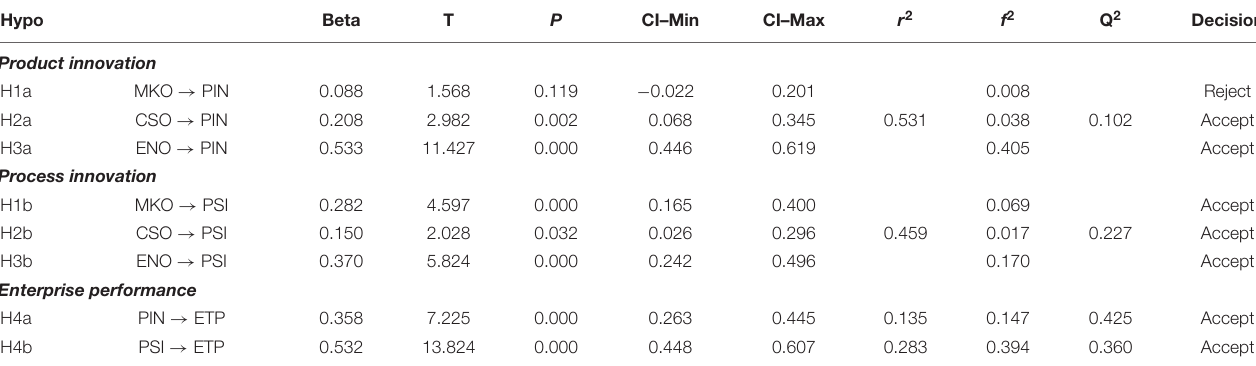
TABLE 3 | Product innovation model.